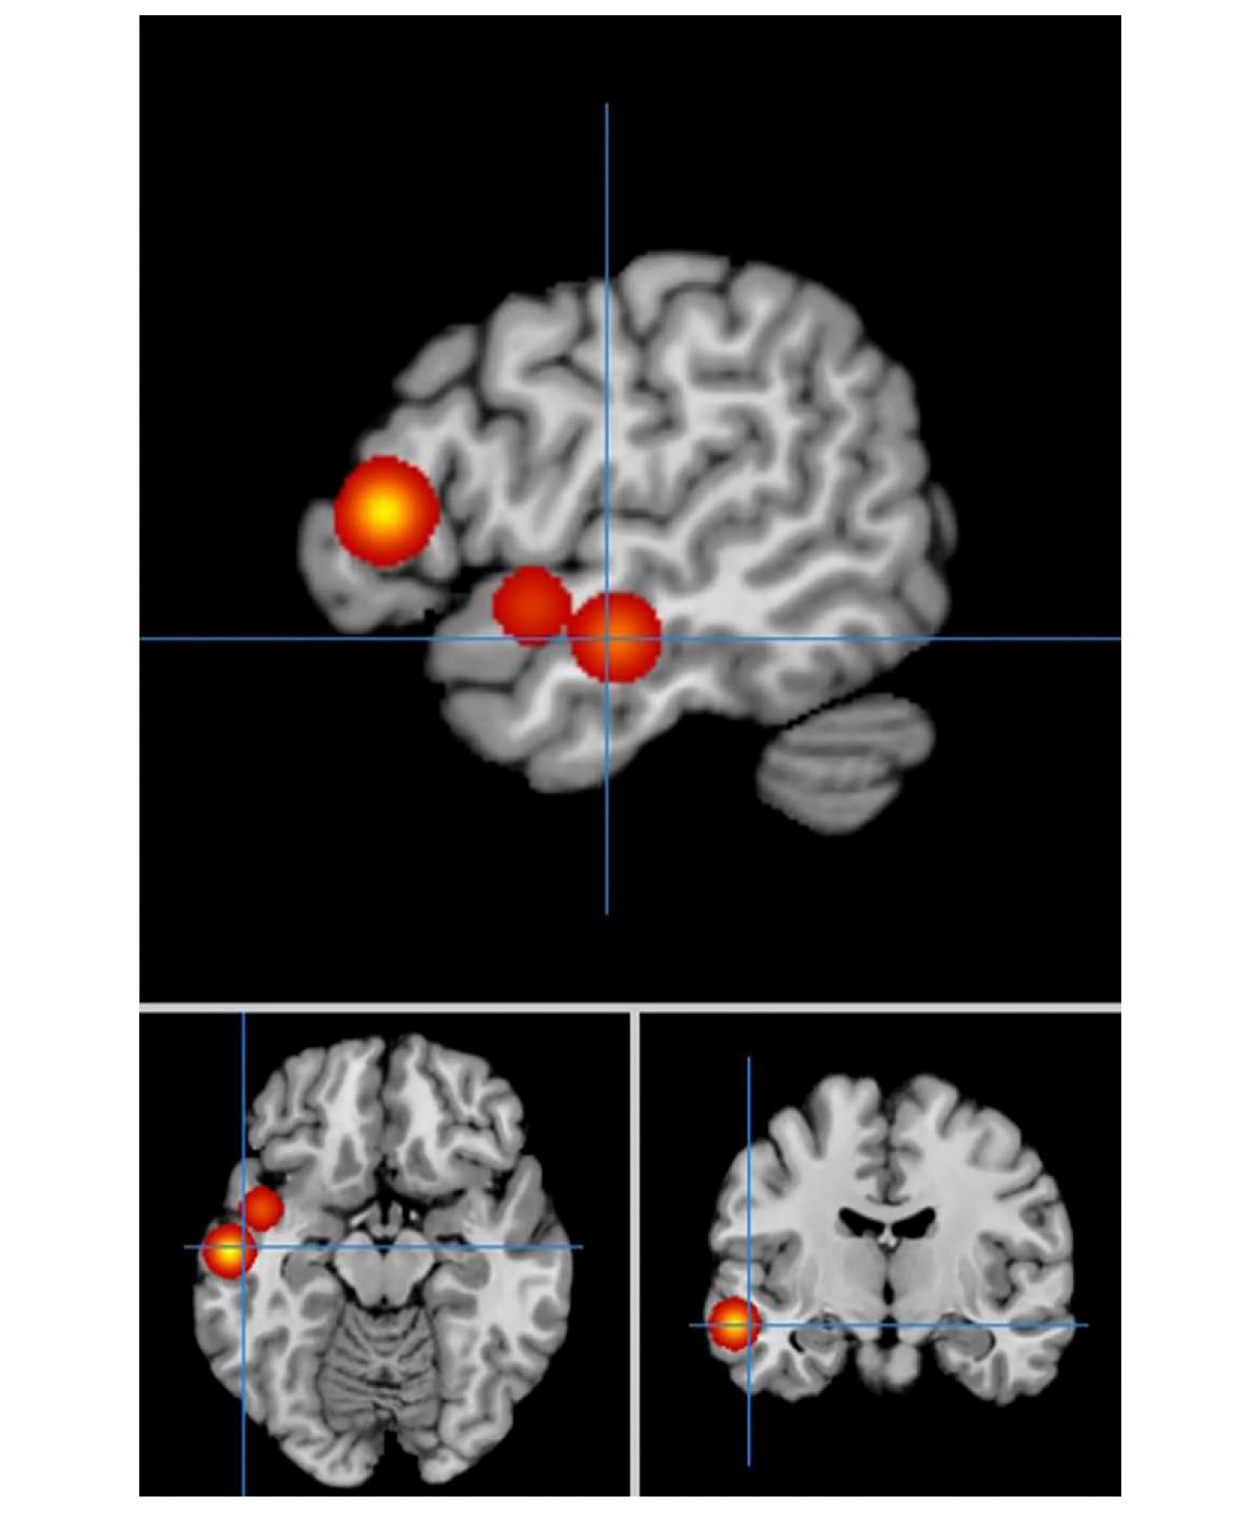
FIGURE 6 | Significant clusters with PD > HC activation in the ALE meta-analysis in cue-priming conditions.